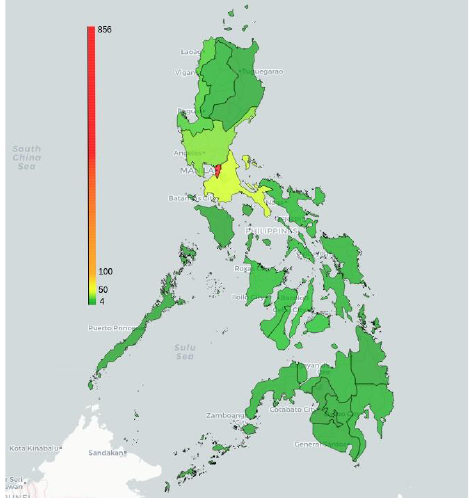
Figure 3 : Average Amenity Accessibility Scores per Region in the